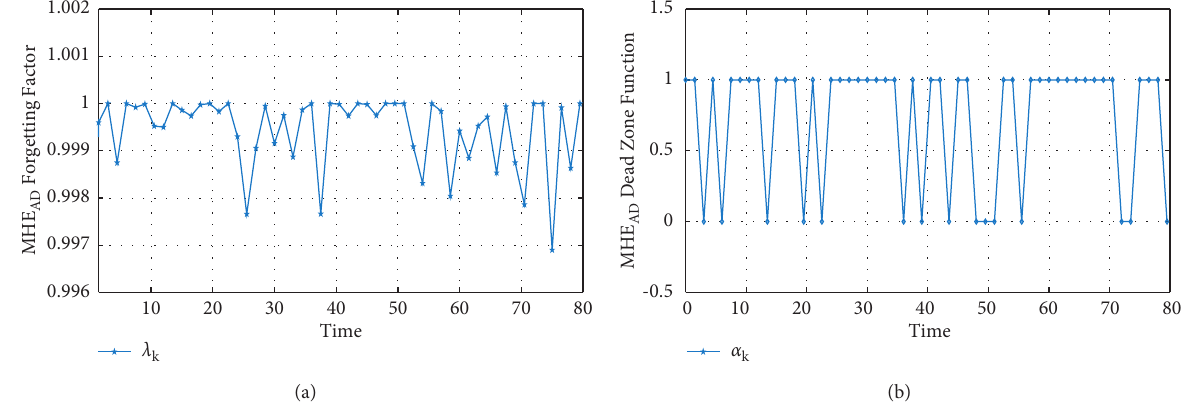
Figure 2: Evolution of the sequence of (a) forgetting factor ( λ